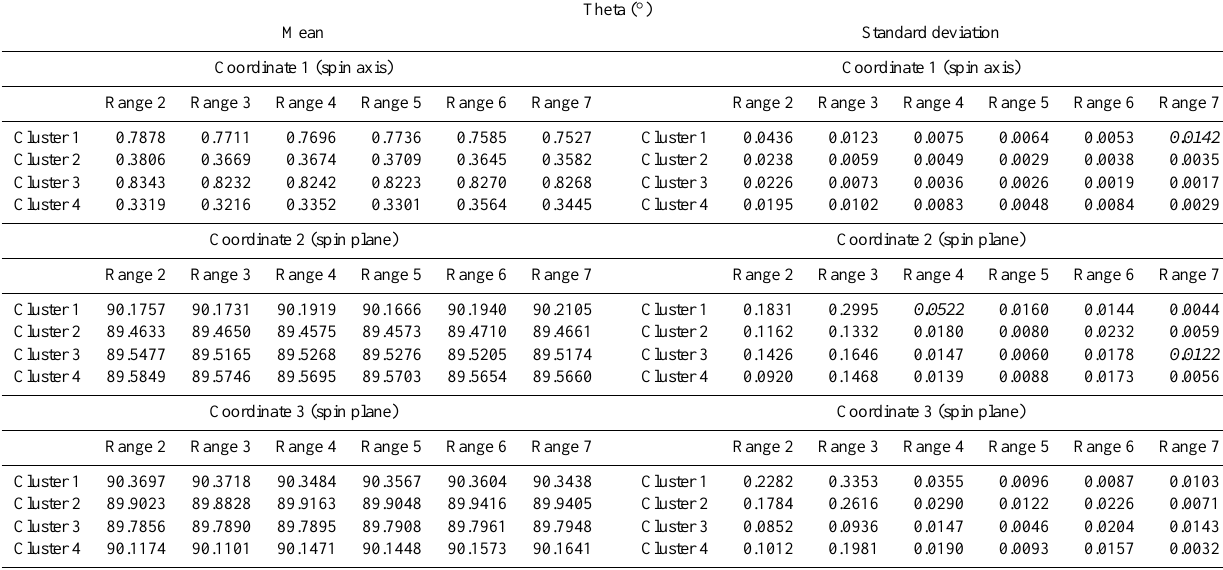
Table 4. Mean and standard deviation of elevation angles ( θ i ) for the mission segment from February 2001 to February 2012 in every range on all spacecraft. Standard deviations for ranges that are at least twice as large as those for all the other spacecraft in that range are highlighted.